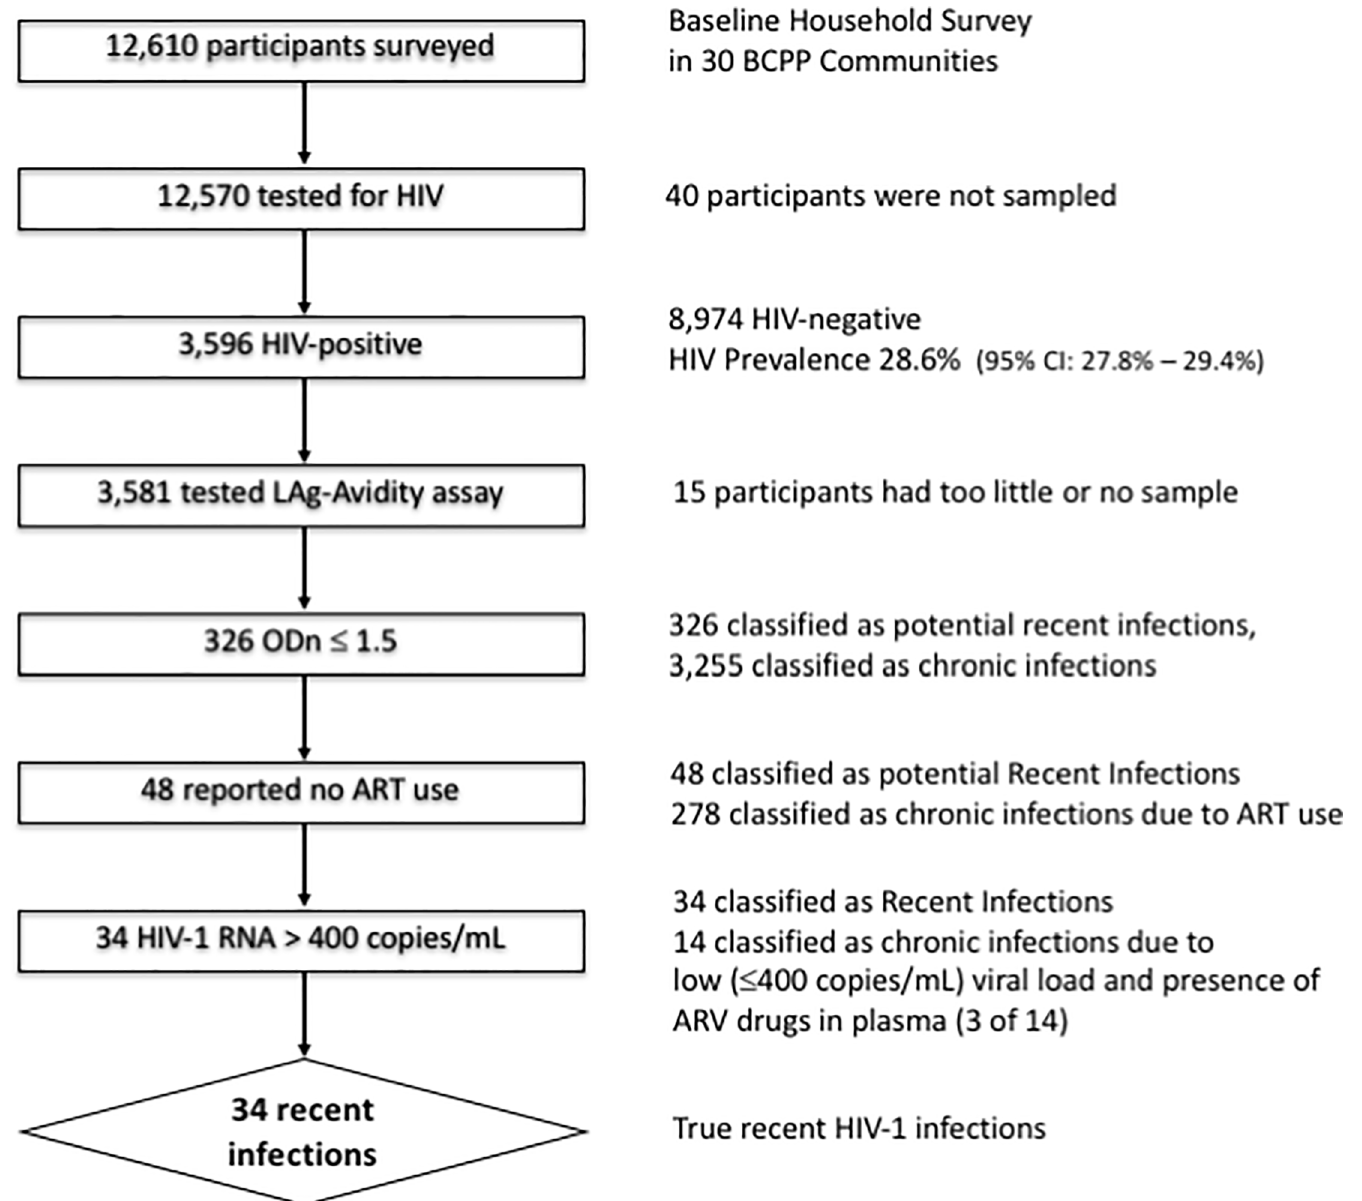
Fig 1. Multiassay algorithm applied for the cross-sectional HIV incidence estimation in Botswana Combination Prevention project.